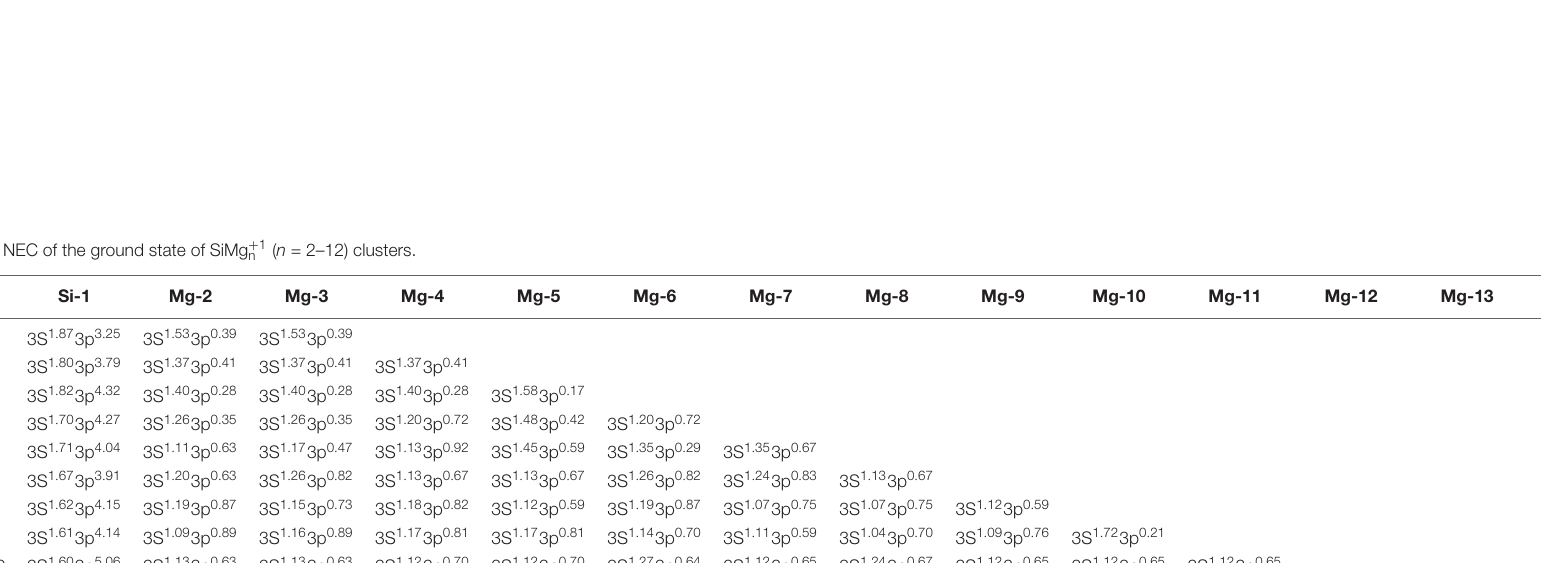
SiMg + 1 11 SiMg + 1 12